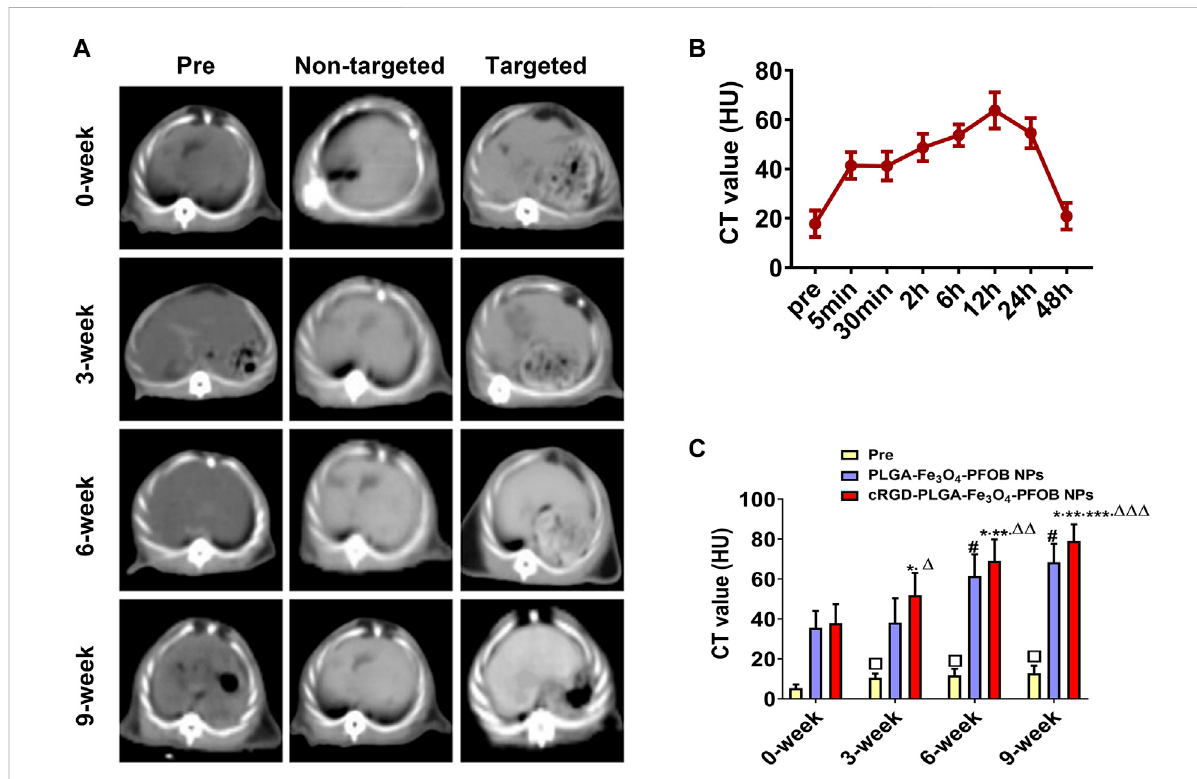
FIGURE 9 Invivo CTimaging. (A) CTimagesofliverbeforeandafterinjectionoftargetedcontrastagents(cRGD-PLGA-Fe contrast agents (PLGA-Fe 3 O 4 -PFOB NPs). (B) CT value of the liver parenchyma in the 0-week group within 48 h after injection of cRGD-PLGA- Fe 3 O 4 -PFOB NPs. (C) Comparison of liver CT values before and after injection of cRGD-PLGA-Fe 3 O 4 -PFOB NPs or PLGA-Fe 3 O 4 -PFOB NPs in each group (* p < 0.05 versus0-week group, ** p < 0.05 versus 3-week group, *** p < 0.05 versus6-week group, # p < 0.05 versus 0-week or 3-week group, Δ P < 0.05 versus non-targeted 3-week group, ΔΔ P < 0.05 versus non-targeted 6-week group, ΔΔΔ P < 0.05 versus non-targeted 9-week group, □ p < 0.05 versus 0-week